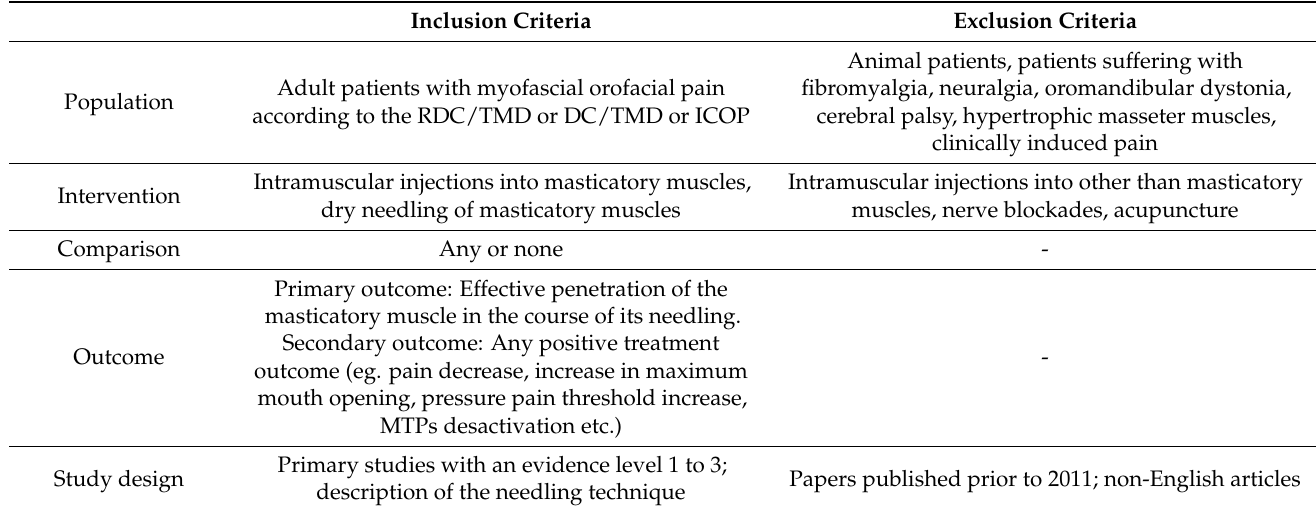
Table 2. The eligibility criteria according to PICOS